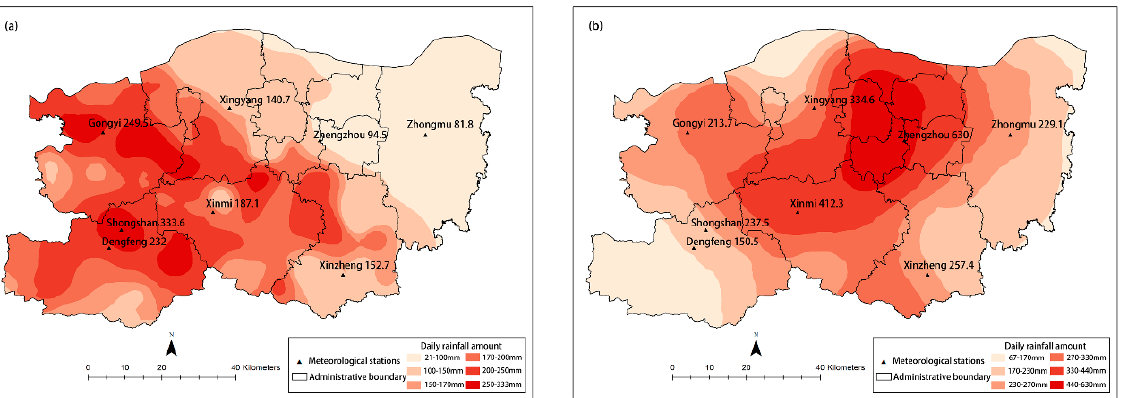
Figure 2. The rainfall patterns from July 19 to 21 2021: ( a ) rainfall amounts from 0600 UTC 19 to 0600 UTC 20 July 2021; and ( b ) rainfall amounts from 0600 UTC 20 to 0600 UTC 21 July 2021.